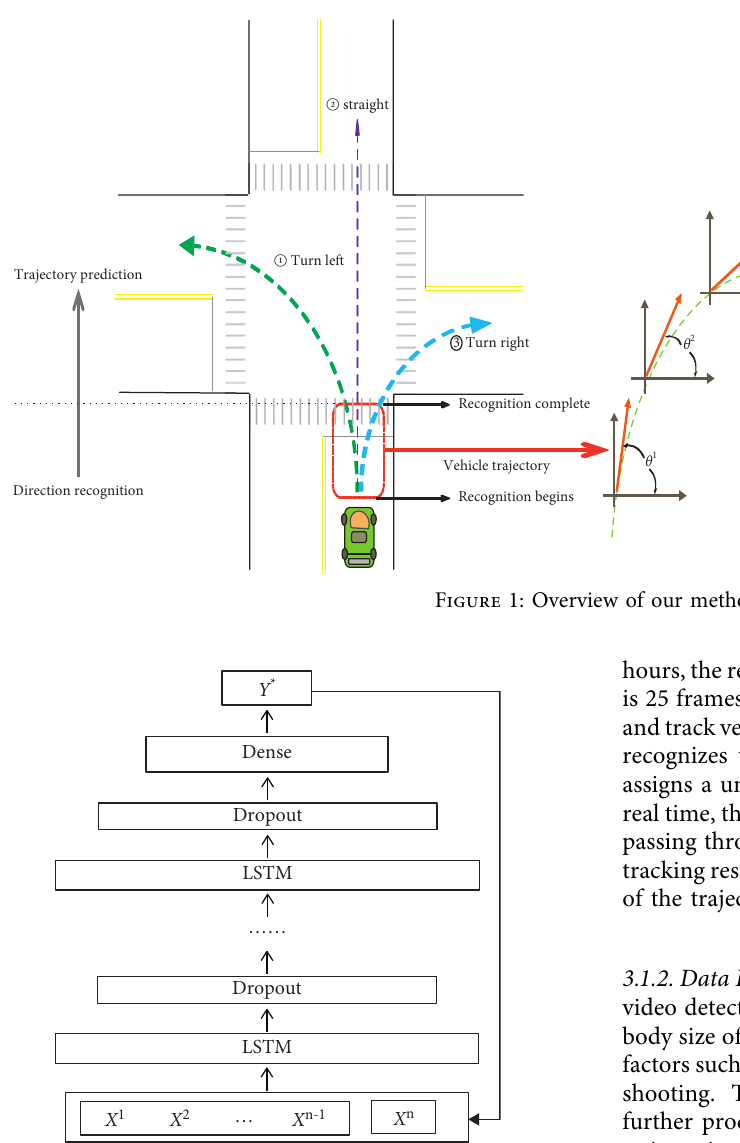
Figure 2: Multilayer LSTM